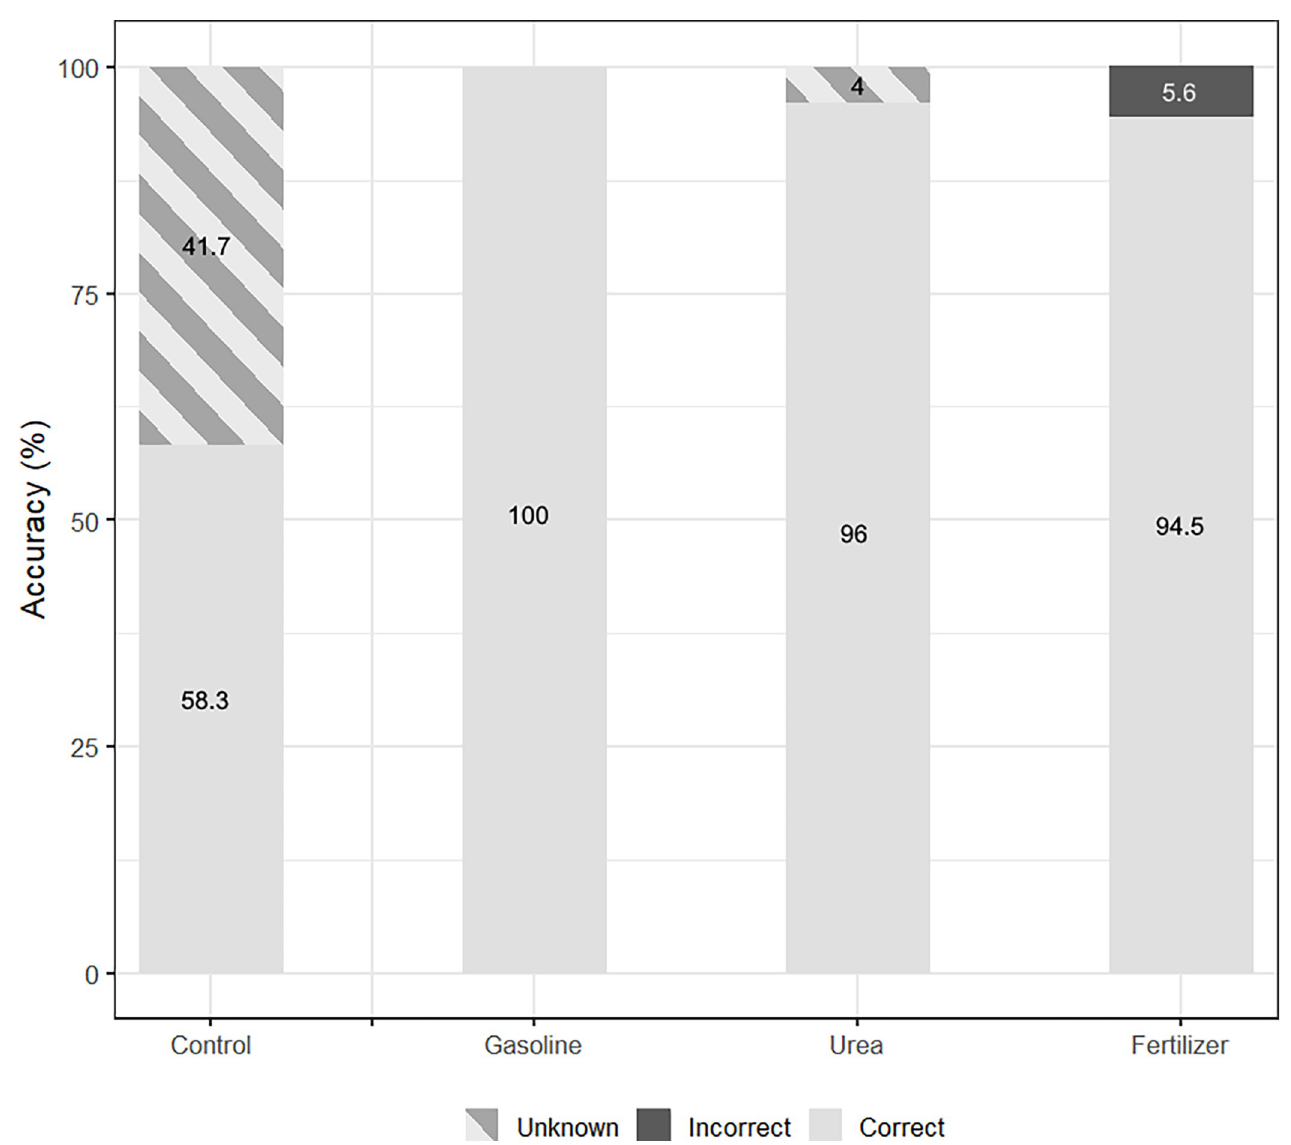
Fig 6. NM500 interpretation of anthropogenic compounds, with only the top 3 most accurate compounds from Fig 5 used for training. Method used is 6-point grouping with Radial Basis function and “Unanimous” interpreter on standardized data. All answers are marked as “Identified”.